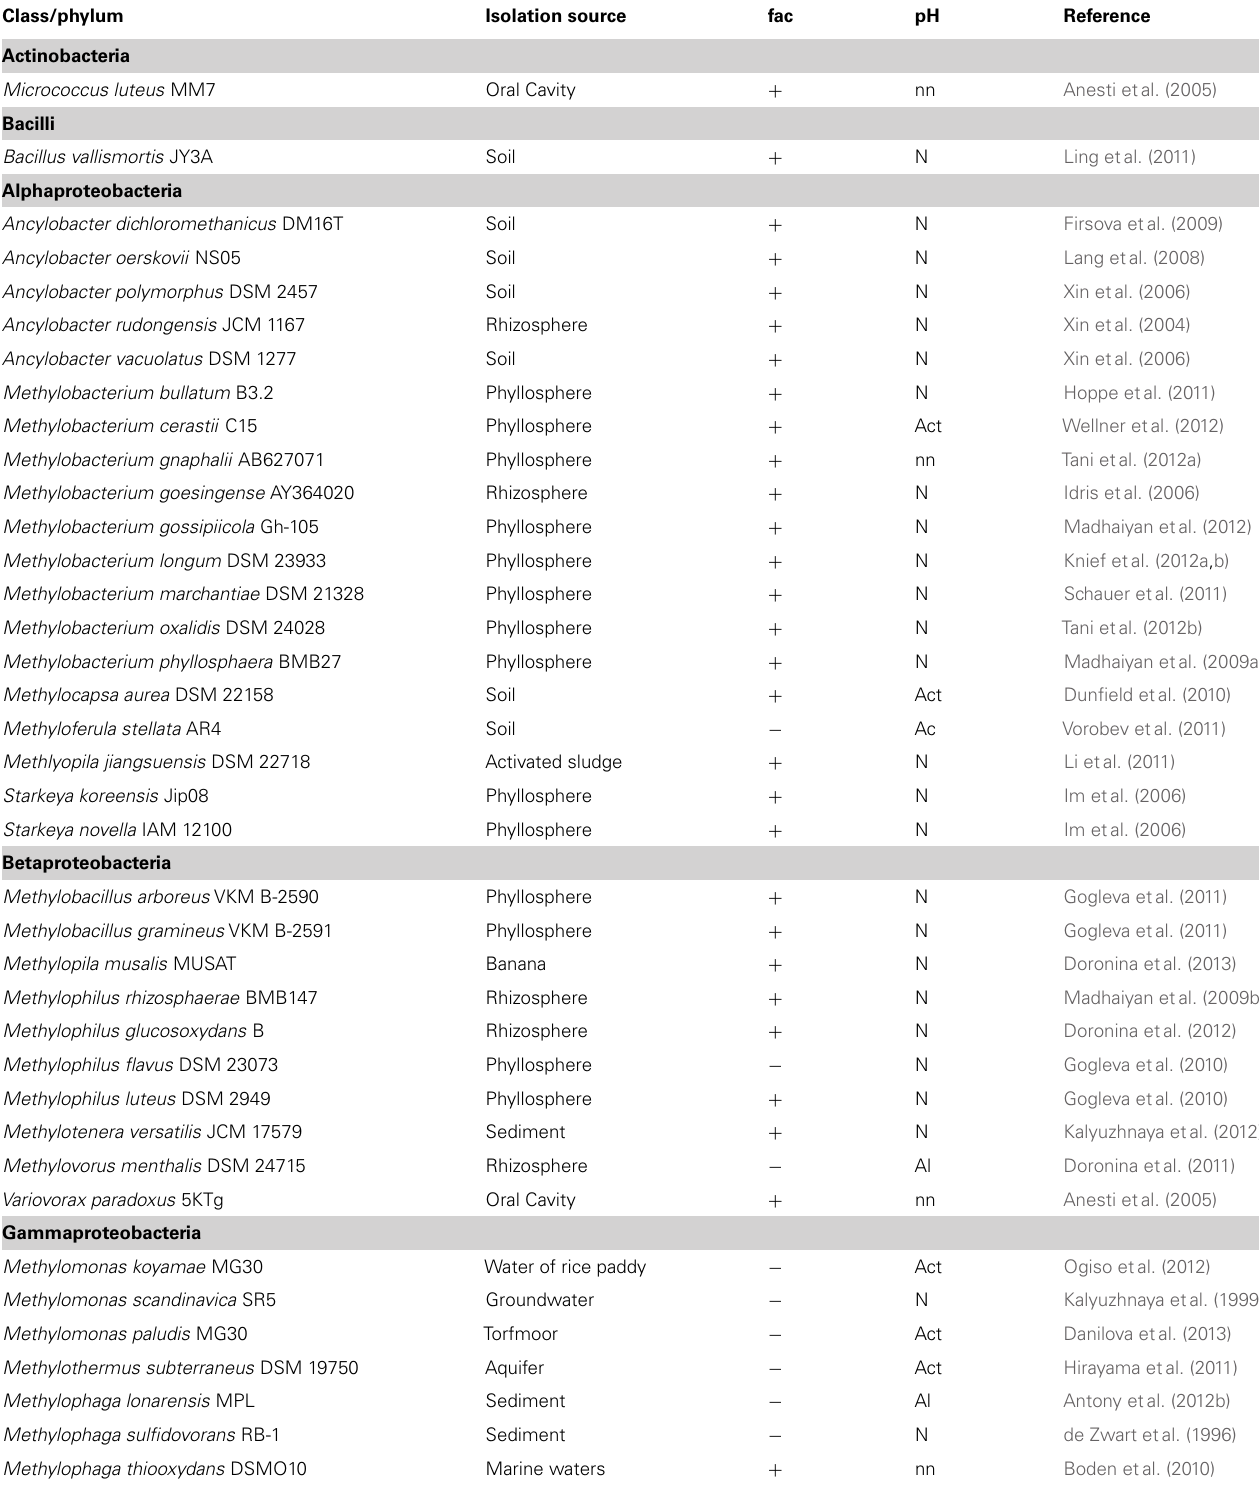
Table 2 | List of methanol-utilizing methylotophs that are not included in a previous survey (Kolb,